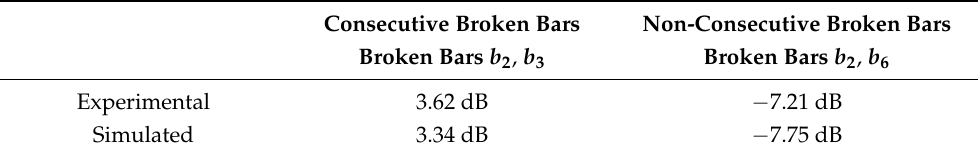
Figure 18. Spectra of the stator current obtained in the experimental tests of the motor of Appendix A with the foll owing cage faults: ( a ) without fault, ( b ) one broken bar, ( c ) two consecutive broken bars (broken bars b 2 , b 3 ) and ( d ) two non-consecutive broken bars (broken bars b 2 , b 6 ). The main fault harmonics have been marked with text arrows, indicating their magnitude. Table 1. Increase of the LSH magnitude in case of a double broken bars fault, at different bar positions, compared with the LSH in case of a single broken bar